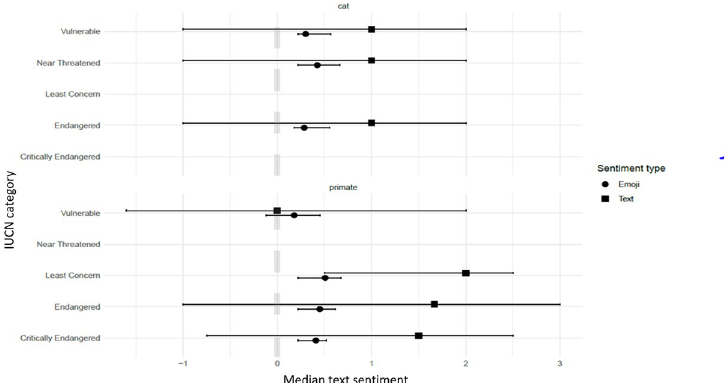
Fig 3. Sentiment and IUCN Red List classification. Median text and emoji sentiment comments score across 346 YouTube 1 videos of exotic wild cat published between 2012 and 2019 associated with species conservation status as listed on the IUCN Red List (2019). Emoji usage within the comments was only present from 2012. Twelve primate compilation videos featuring four or more compiled videos with various species were not provided with an IUCN Red List Classification due to ambiguity and as such have not been included. Median sentiment score ranged between -1 (negative) and +1 (positive), where 0 is neutral, in accordance with the software utilised. Error bars represent first to third quartiles.